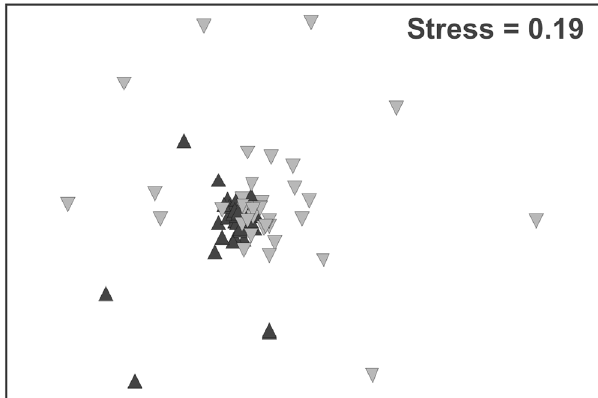
Fig. 1. Non-Metric Multi-Dimensional Scaling (MDS) plot of fish assemblages samples of the Picãozinho reef in each of the two studied situations. Dark triangles = PT (presence of tourists) and light triangles = AT (absence of